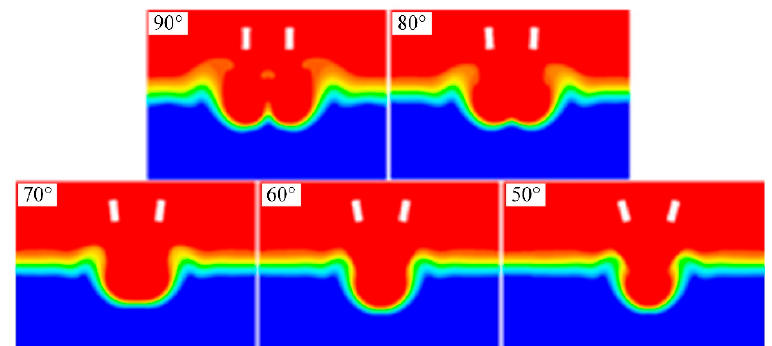
Figure 10. Numerical simulation results of different jet angles.